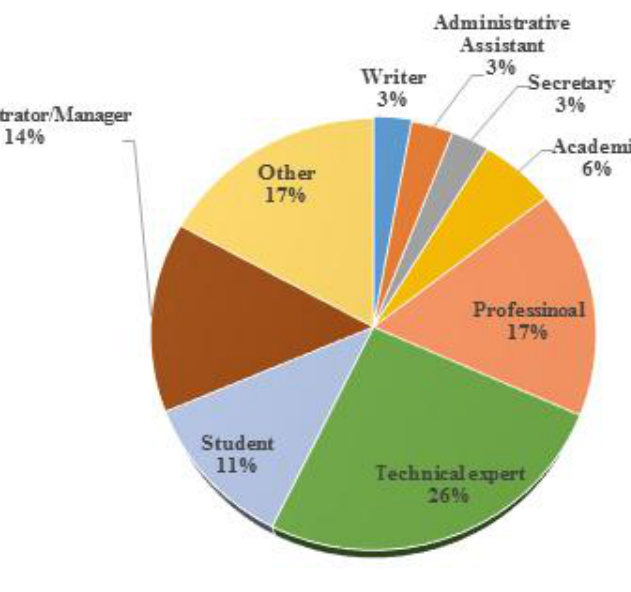
Fig. 6: Work status